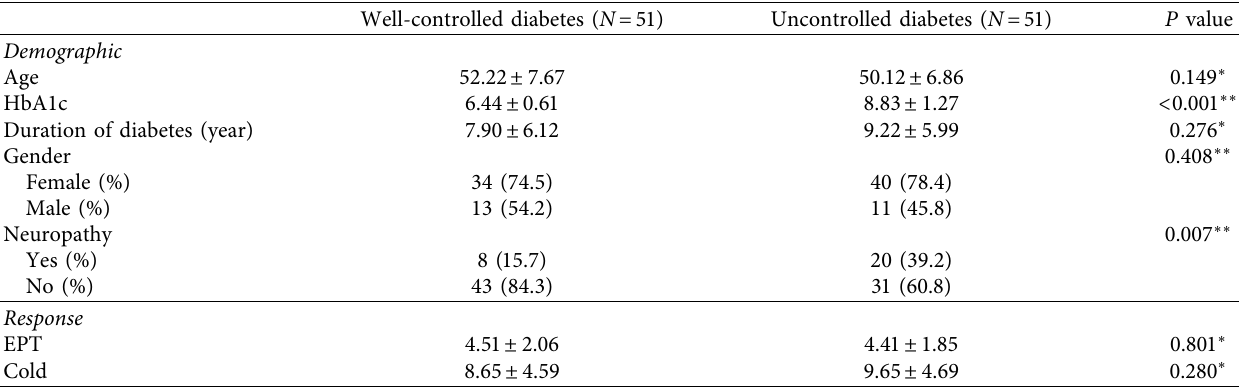
Table 1: Comparison of demographic characteristics and pulp responses of two groups with well-controlled and uncontrolled diabetes.